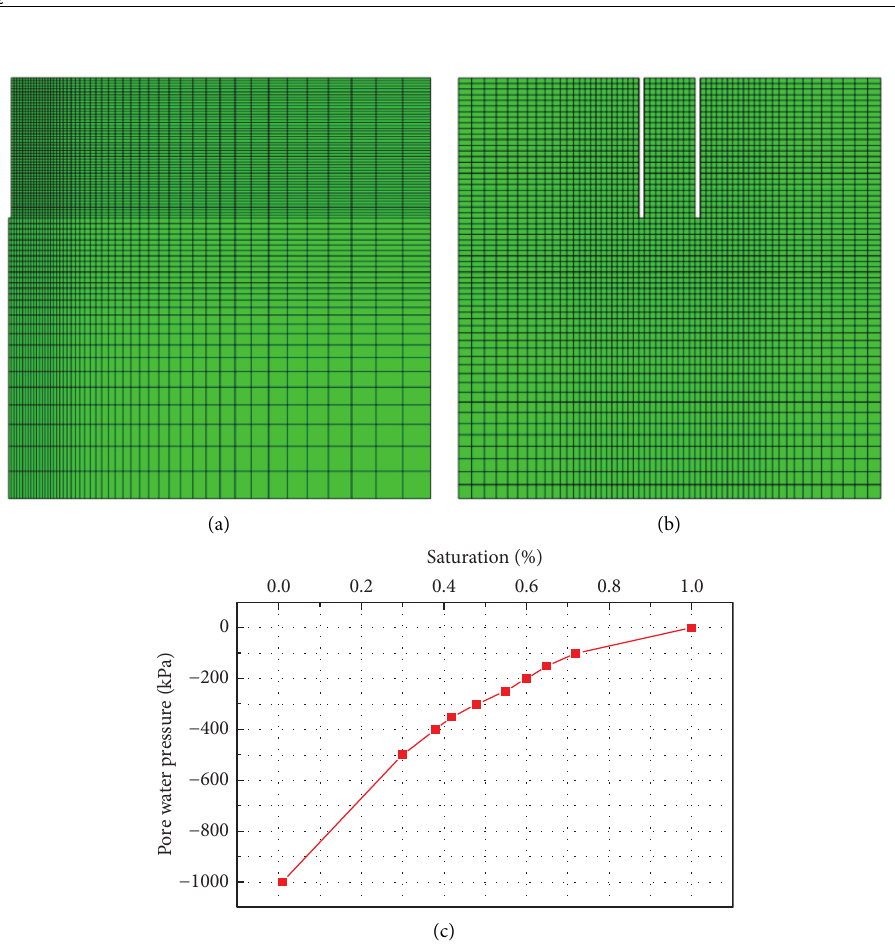
Figure 5: (a) Calculation model of the single water injection hole. (b) Calculation model of double water injection holes. (c) Moisture absorption curve.